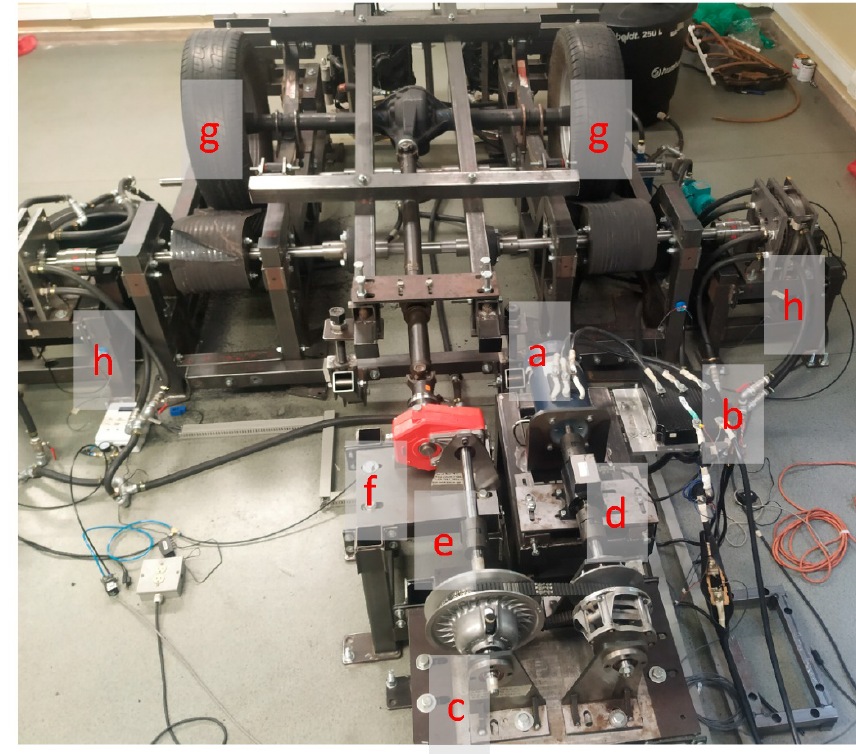
Figure 8. Dynamometer used for model evaluation.